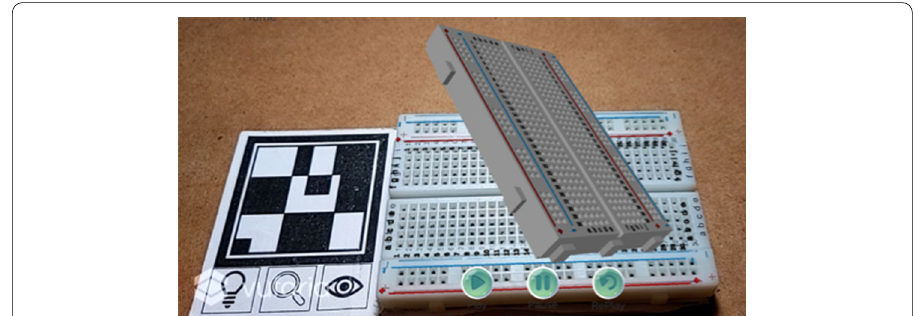
Fig. 7 (Bottom) New transparent shader (virtual) overlayed on physical breadboard, power and ground rails, numbering and letters of breadboard are the non-transparent features. (Top) Previous solid shader, which had to be discarded due to occlusion